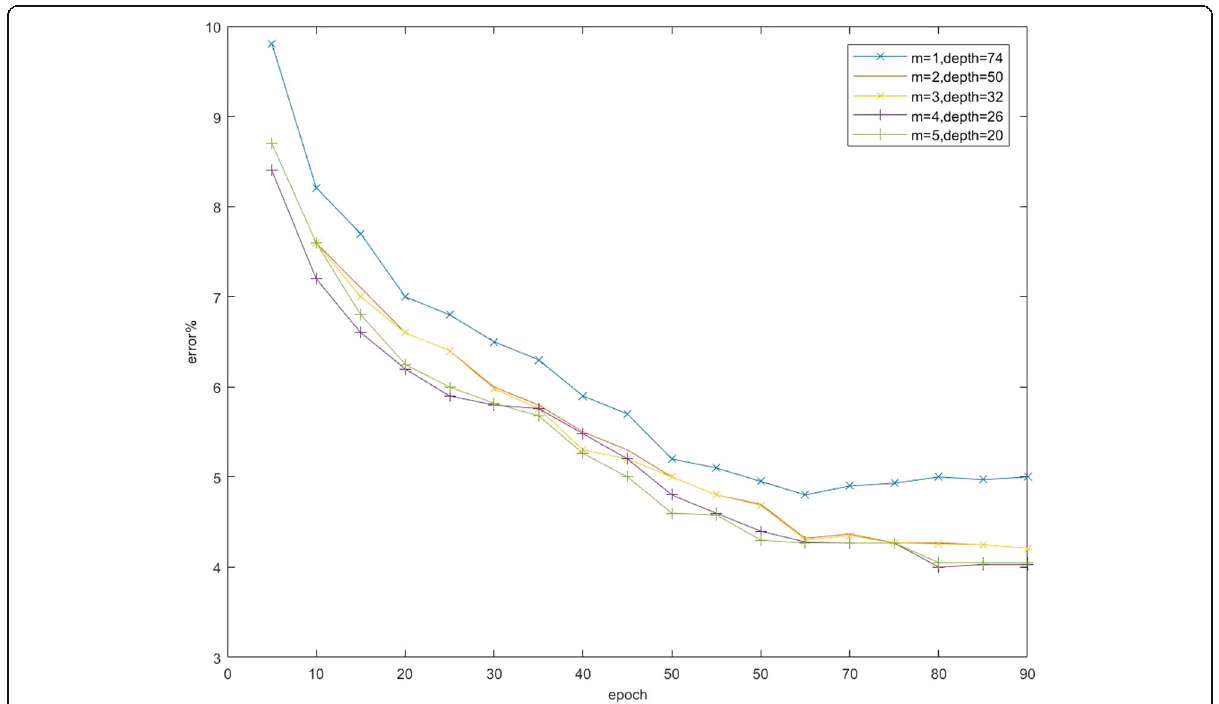
Fig. 8 Test set error rate – training times curve